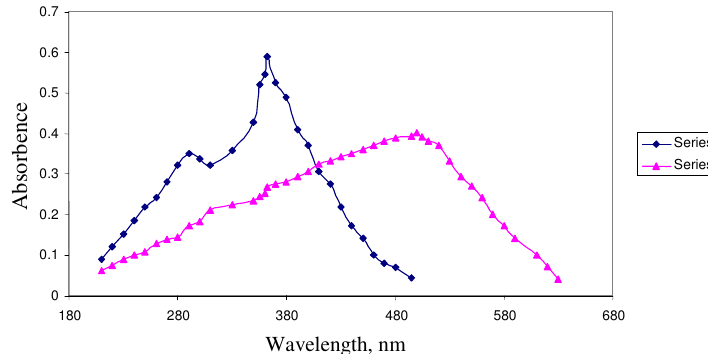
Figure 1. Absorption spectra of (1) Flucloxacillin (9 µg) in methanol and iodine 1.0 mL of 0.1% in dichloromethane (2) Iodine (1.0 mL of 0.1%) in dichloromethane in 10 mL volumetric